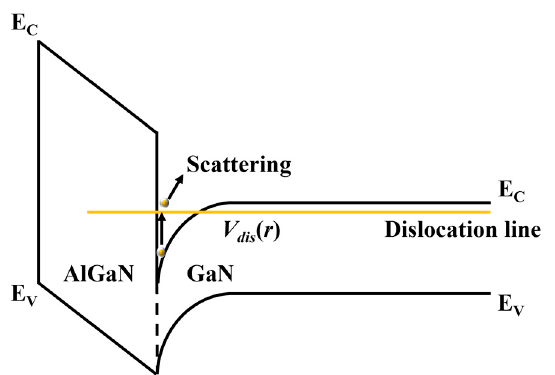
Figure 2. Schematic diagram of dislocation scattering mechanism. Figure depicts energy band of GaN/AlGaN heterostructure when a threading dislocation penetrates through GaN/AlGaN heterojunction. Carriers transport along channel and scatter due to scattering potential V dis ( r ) generated by dislocation line.